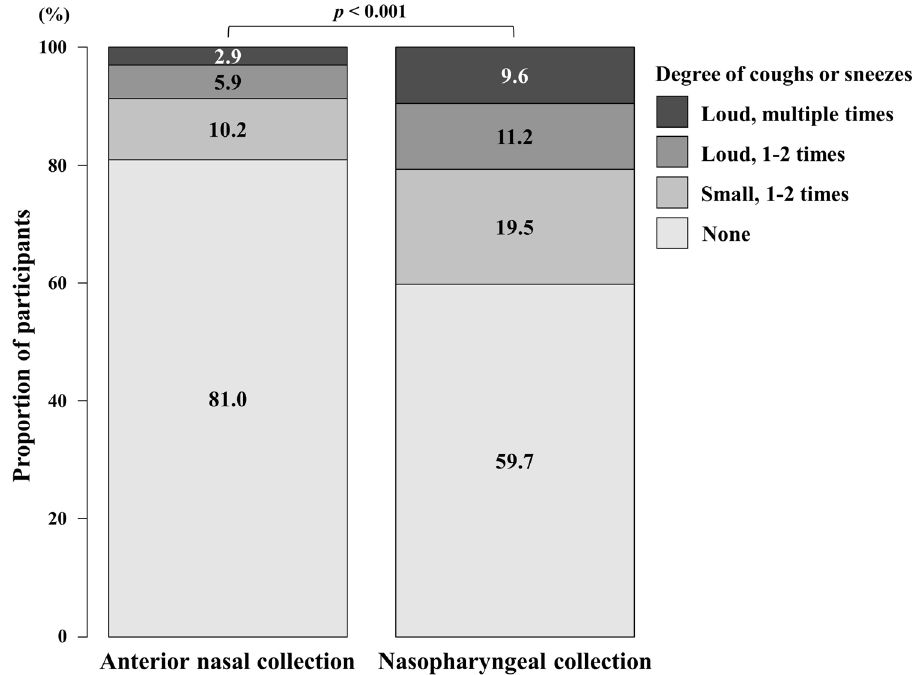
Figure 2. Degrees of coughs or sneezes induced by anterior nasal and nasopharyngeal collection. The degrees of coughing or sneezing following swab insertion was compared between anterior nasal collection